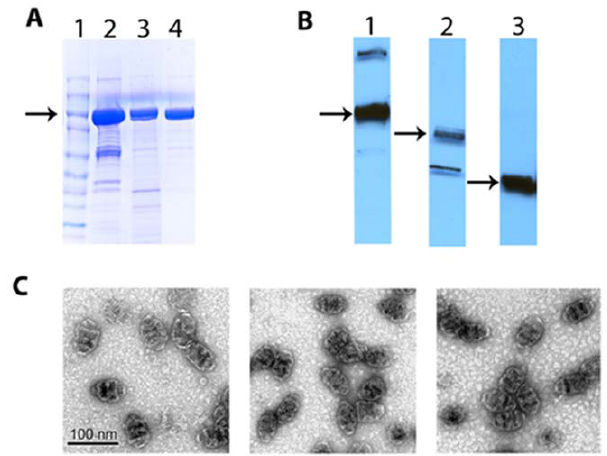
Figure 1. Evaluation of recombinant CCL21-vaults. A. Coomassie stain of purified vaults fractionated on a 4–16% SDS-PAGE. Lane 1, molecular weight markers. Lane 2, mCCL21-mCherry-INT/CP-MVP vaults. The 97-kDa MVP band is indicated by the arrow. Lane 3, hCCL21-INT/CP-MVP vaults. Lane 4, CP-MVP vaults. B. Western blot analyses of purified vaults to confirm the presences of MVP or the indicated INT fusion proteins (arrows). Lane 1, mCCL21-mCherry-INT/ CP-MVP vaults were immunoblotted with anti-MVP antibody. Lane 2, mCCL21-mCherry-INT/CP-MVP vaults were immunoblotted with anti- INT antibody. Lane 3, hCCL21-INT/CP-MVP vaults were immunoblotted with anti-INT antibody. C. Negative-stained electron micrographs of purified vaults. CP-MVP vaults (left), mCCL21-mCherry-INT/CP-MVP vaults (center), hCCL21-INT/CP-MVP vaults (right).